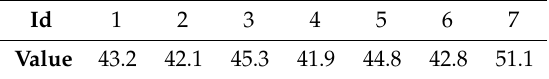
Table 3. The historical data of SOF.